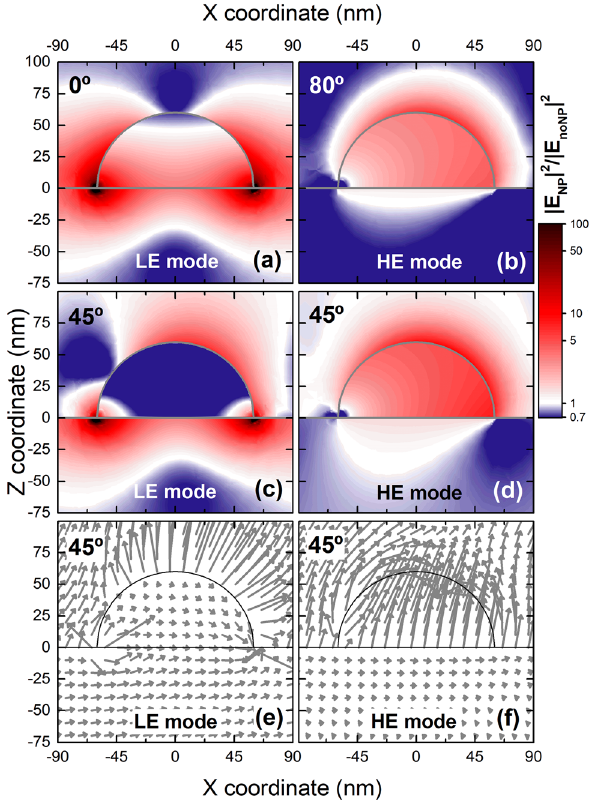
Figure 4: (a – d) Enhancement of the squared electric field, defined as the ratio of the squared module of the electric field with and without NPs, for both modes and different angles of incidence (0 ° , 45 ° , and 80 ° ) in p -polarization. (e – f) Electric fi eld vector at a 45 ° angle of incidence for the LE mode (e), and HE mode (f). Arrow lengths are proportional to the fi eld module. The incident wave impinges from the top-left side of the